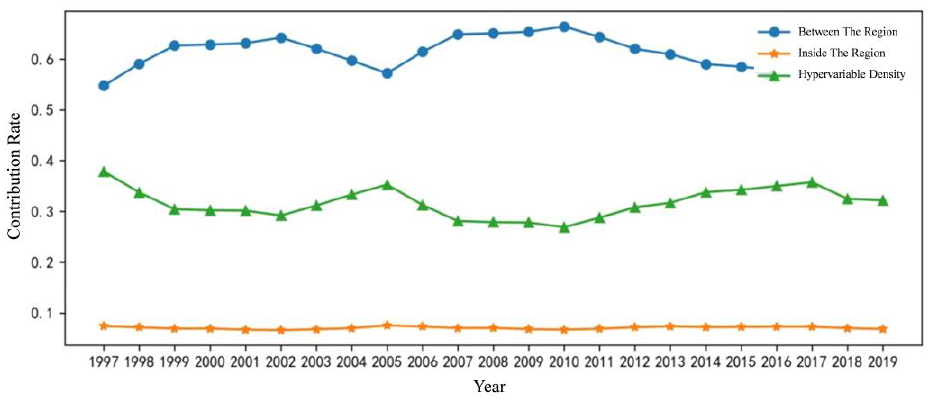
Figure 4. Change chart of national and regional contribution rates.